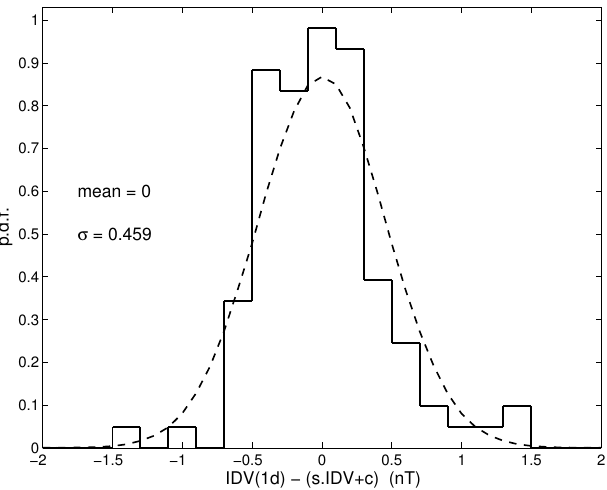
Figure 31: The distribution of fit residuals 𝐼𝐷𝑉 (1 𝑑 ) − ( 𝑠.𝐼𝐷𝑉 + 𝑐 ) for 1966 – 2012, where 𝑠 and 𝑐 are the best-fit linear regression coefficients. The mean of the distribution is 0nT to within 5 decimal places. The standard deviation is 0.459 nT. The dashed line is the best-fit Gaussian distribution of the same mean and standard